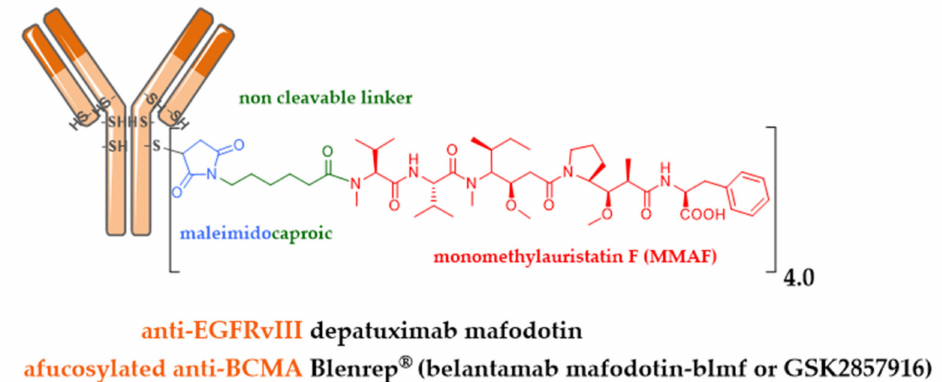
Figure 13. Formula of depatuximab mafodotin and Blenrep ® (belantamab mafodotin-blmf), antibodies conjugated to MMAF via a non-cleavable